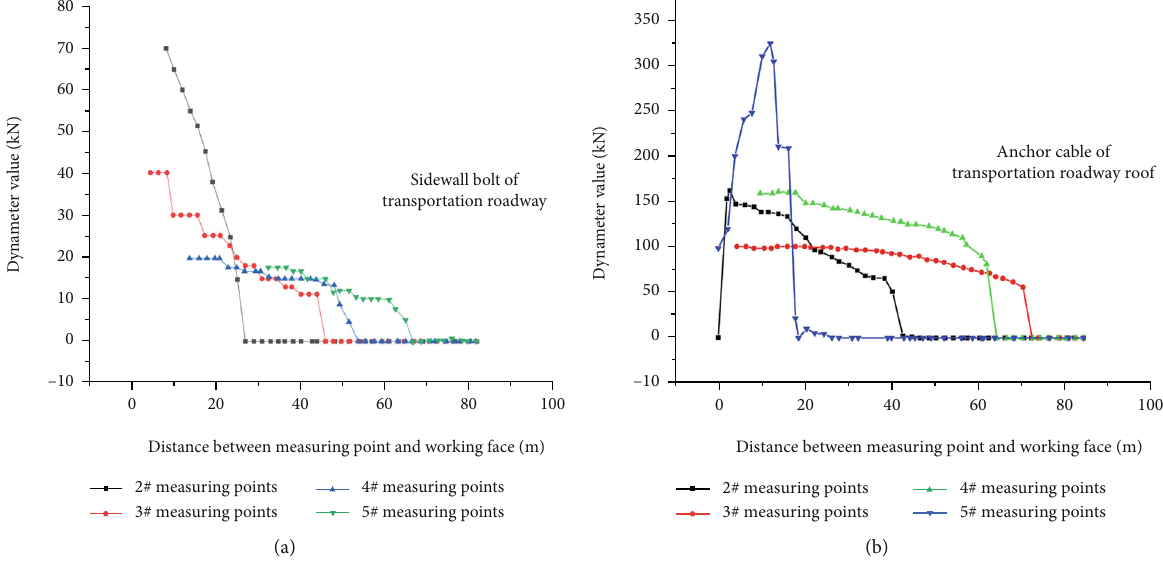
Figure 7: Relationship between the pressure value of dynameter in transportation roadway and the distance from the working